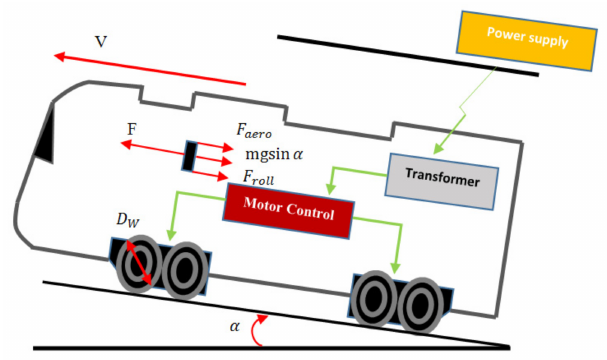
Figure 1. Electric traction